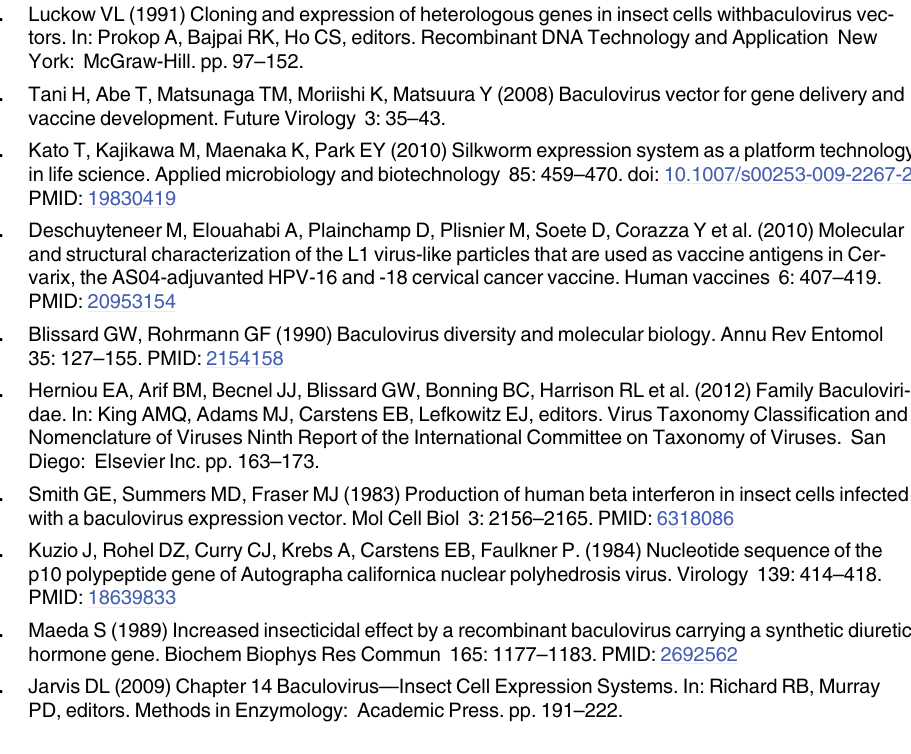
S1 Fig. Quantitative analysis of EGFP yields to test the effects of SV40 polyA on EGFP expression in the baculovirus expression vector system. A pair-wise comparison between viral constructs with and without the SV40 polyA in Sf21 cell infection by fluorescence mea- surement. Sf21 cells were infected by different viral constructs at an m. o. i. of 1 p.f.u/cell and cells were harvested at 72 h post infection for fluorescence emission measurement in triplicate of three independent cell infections. (cid:1) indicate significant difference at P = 0.05. Error bars denote SD. S1 Table. A list of primers used in PCR to analyze the egfp gene